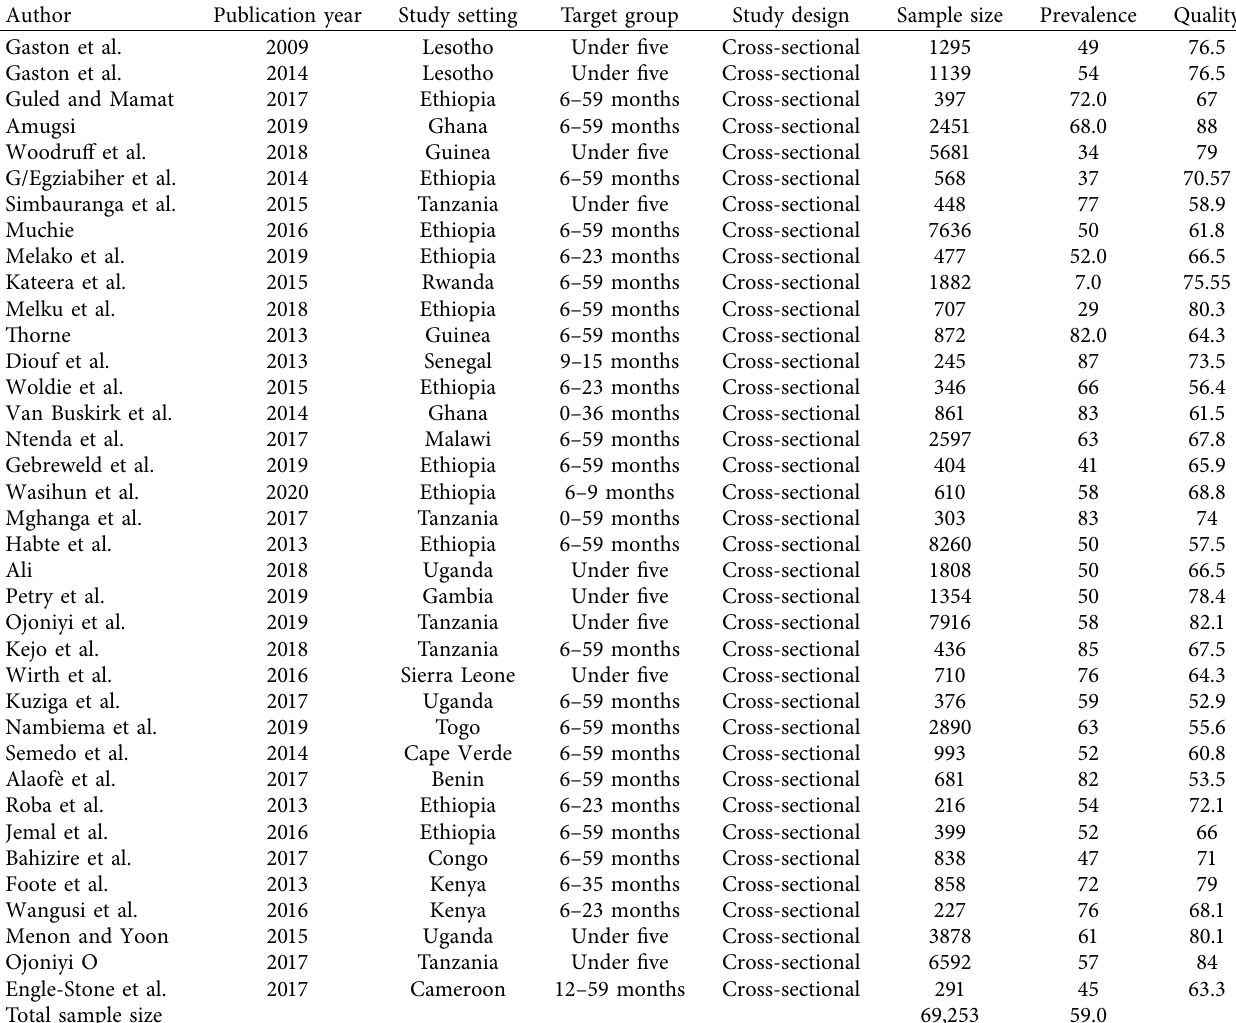
Table 1: Summary of extracted studies on anemia among under-five children in Africa,